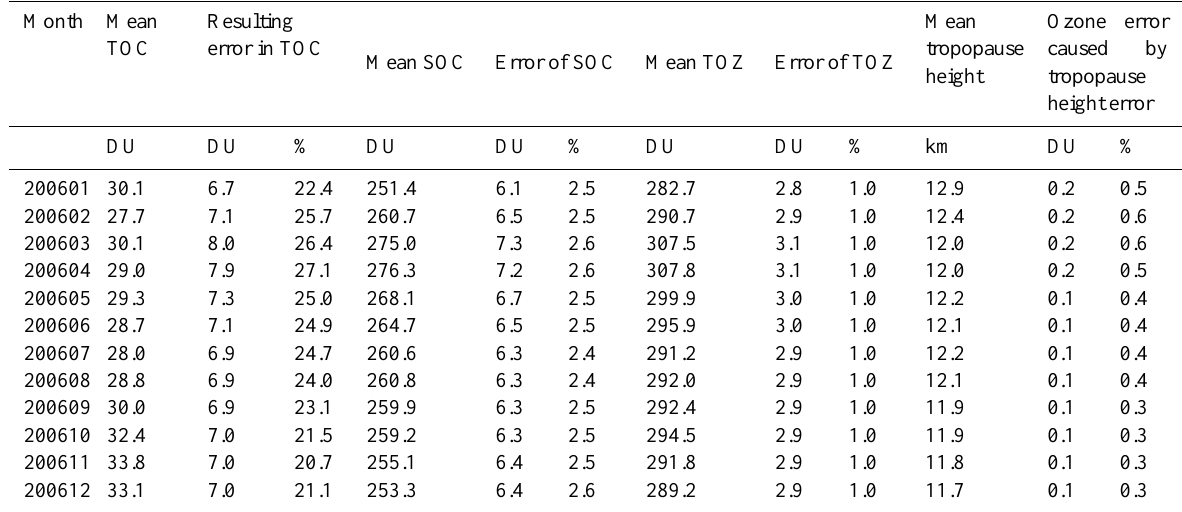
Table 1. Monthly average and errors in TOCs, SOCs, TOZs, and the effect of the tropopause height error determined in 2006. The error in the monthly mean represents one standard